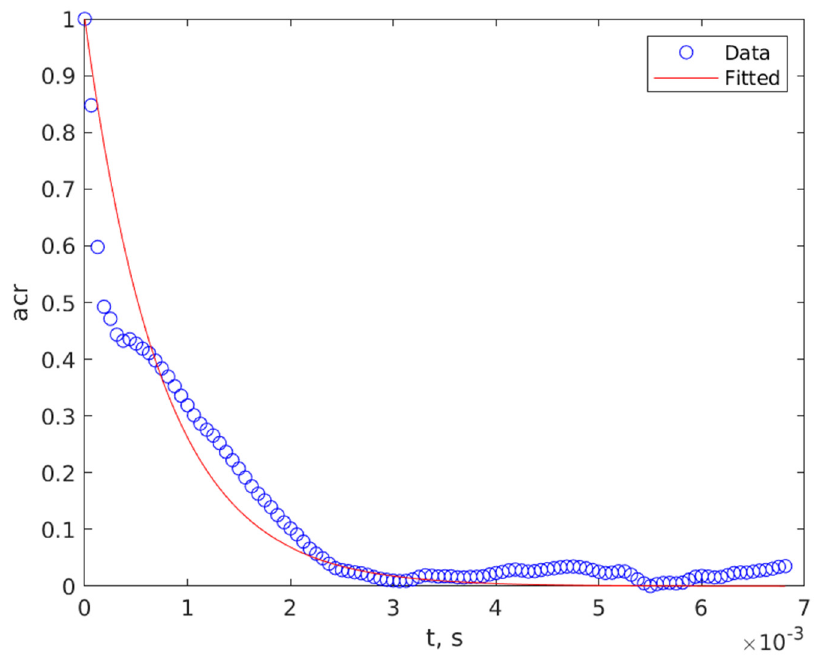
Figure 9. The ACR of a recorded TS, blue circles; and the best fit, continuous red line.